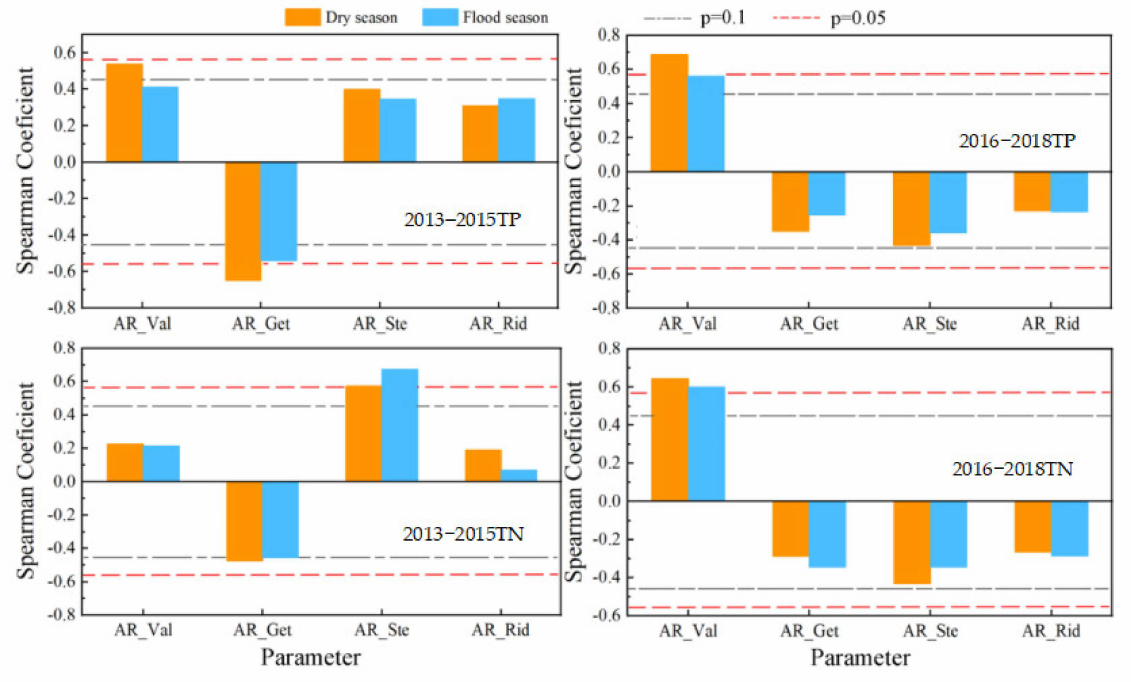
Figure 15. Correlations between topographic positions and TP and TN